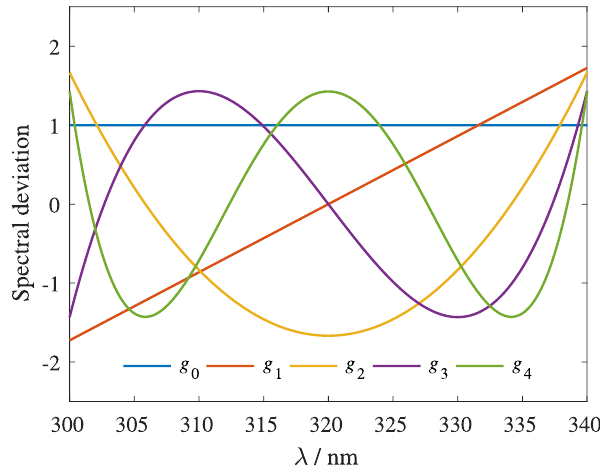
Figure B1. First five Chebyshev polynomials with unity variance corresponding to Fig. 4 with sinusoidal base functions.